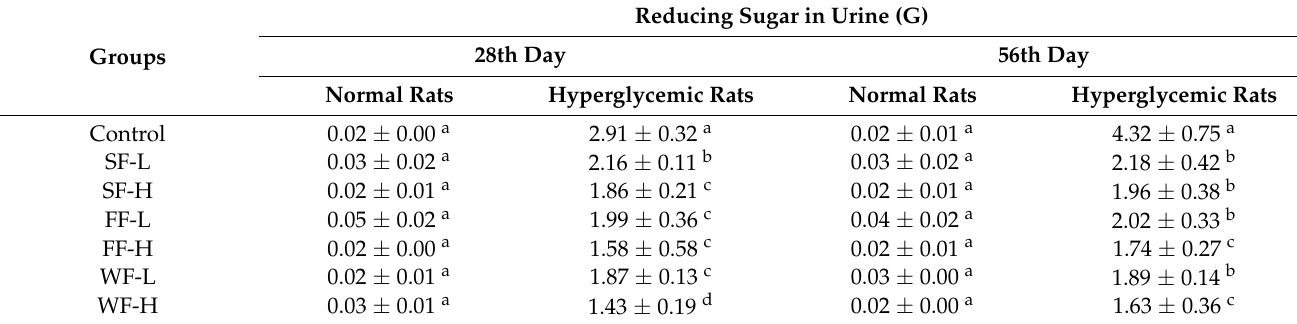
Table 5. Impact of bitter melon supplementation on reducing sugar in urine.